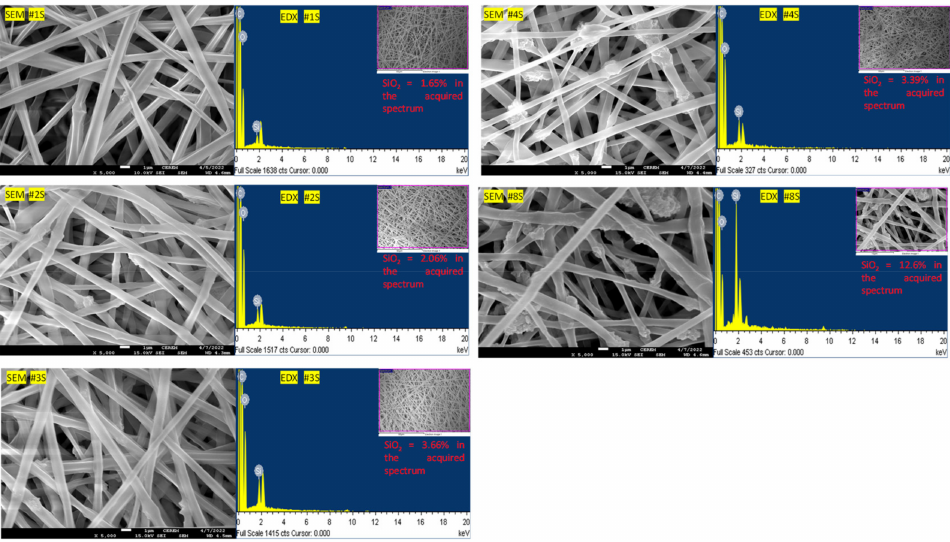
Figure 2. FE-SEM images and EDX results of the electrospun PLA/PEG-PPG-PEG/SiO 2 nanofibrous adsorbents containing the various concentrations of SiO 2